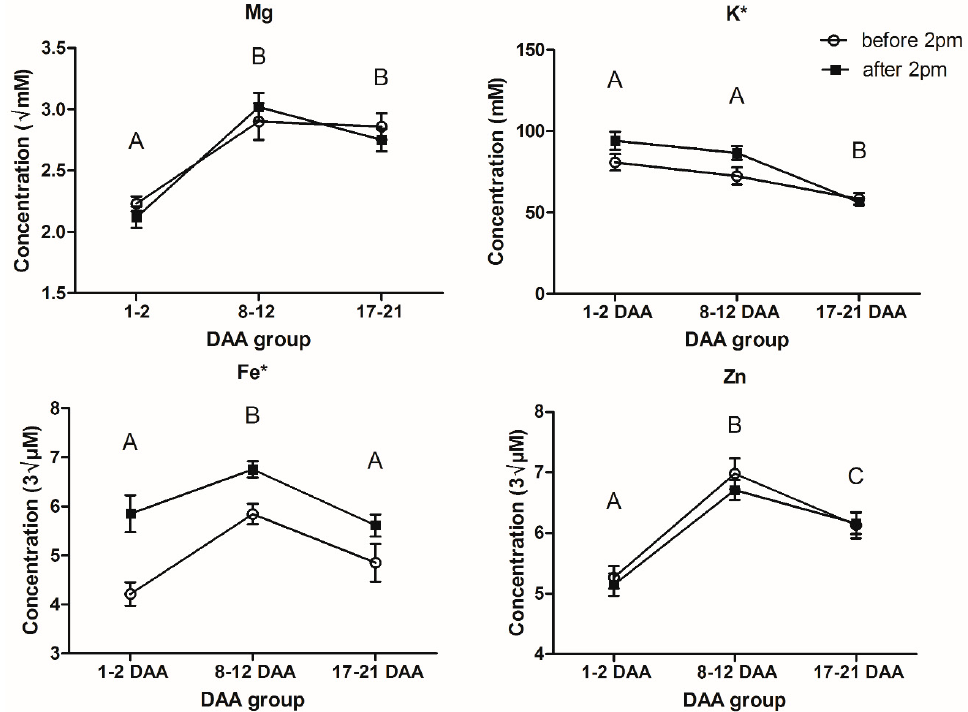
Figure 1. Mean concentrations ± standard error of Mg, K, Fe and Zn in the phloem exudate sampled before and after 14:00 for different maturities. Letters indicate significant differences between maturities at p < 0.05; * indicates significant differences between time of day at p < 0.05 (DAA, days after anthesis; sample sizes are listed in Table S1, while Table S3 presents the mean and SE for elemental concentrations at each sampling point). Table 2. Hochberg GT2 post hoc test results for comparing maturity groupings after two-way ANOVA. DAA Group Mean Element Difference